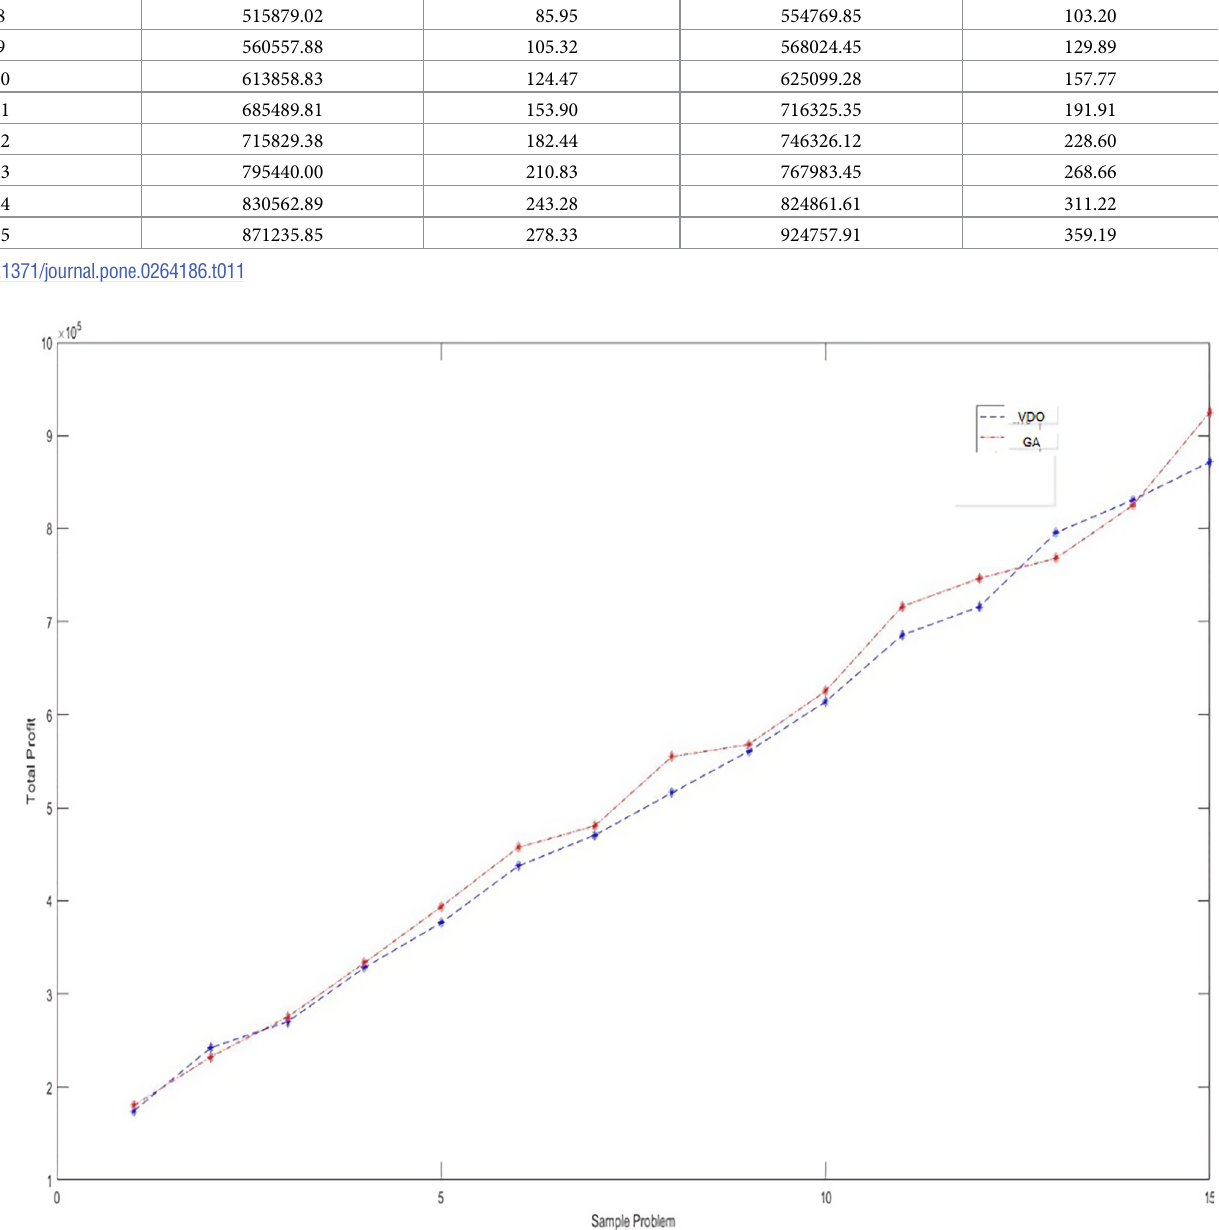
Fig 11. The trend of the objective function for the large-sized test